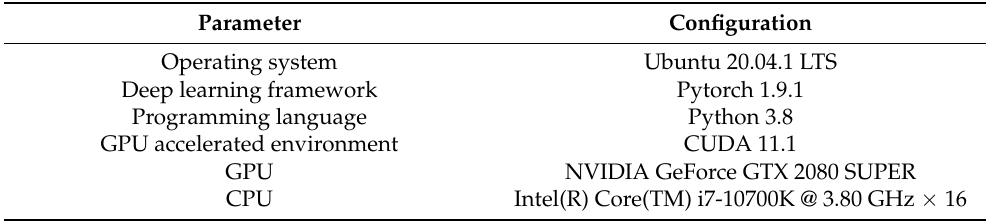
Table 1. Test environment